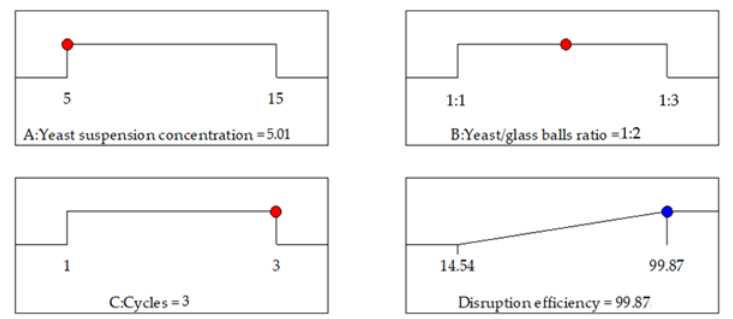
Figure 3. Optimal values of the factors and disruption efficiency.